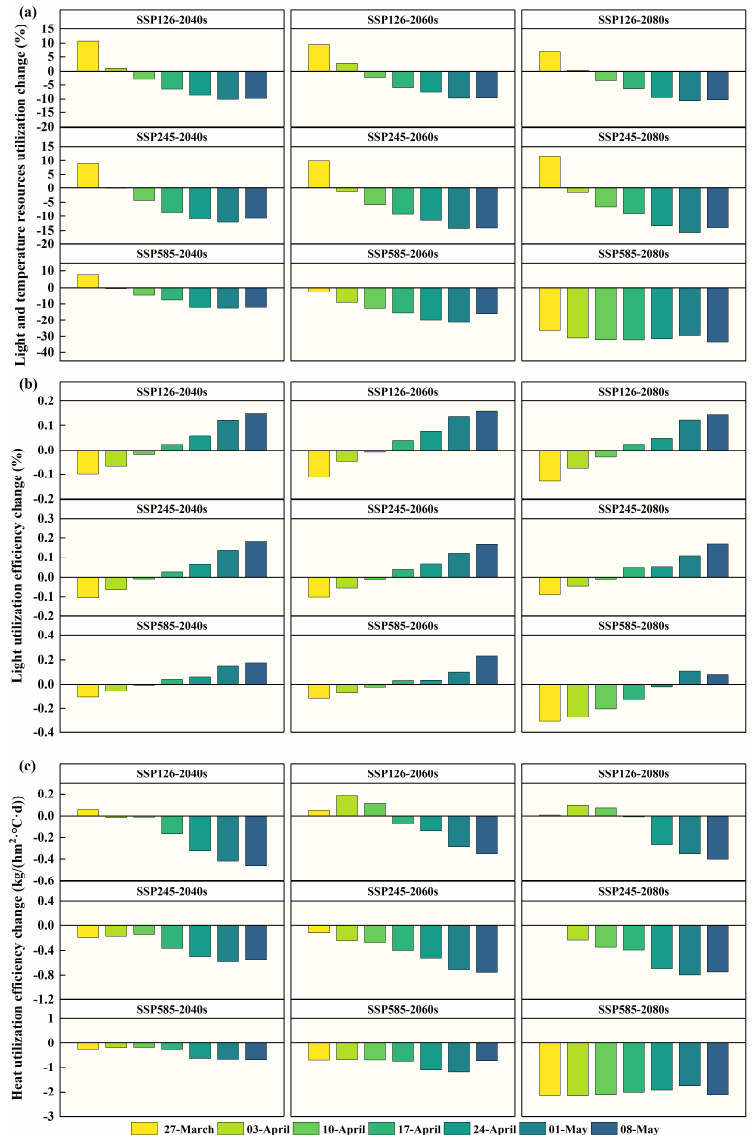
Figure 9. Simulated change in the light and heat resource utilization indices under different sowing dates in the 2040s, 2060s, and 2080s under SSP126, SSP245, and SSP585 scenarios based on the six GCMs compared with sowing on 17 April 2000–2019 for Qing’an station in the Songnen Plain.